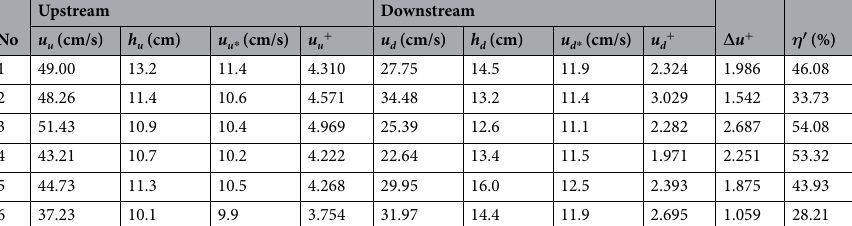
Table 3. Calculations of dimensionless near-bed velocity and the corresponding rates of deceleration for each test. Note: u u = measured value of near-bed velocity upstream of the TFPW; h u = flow depth upstream of the + = non-dimensional near-bed velocity upstream of the = shear velocity upstream of the TFPW; u TFPW; u u u * TFPW; u d = measured value of near-bed velocity downstream of the TFPW; h d = flow depth downstream of the TFPW; u